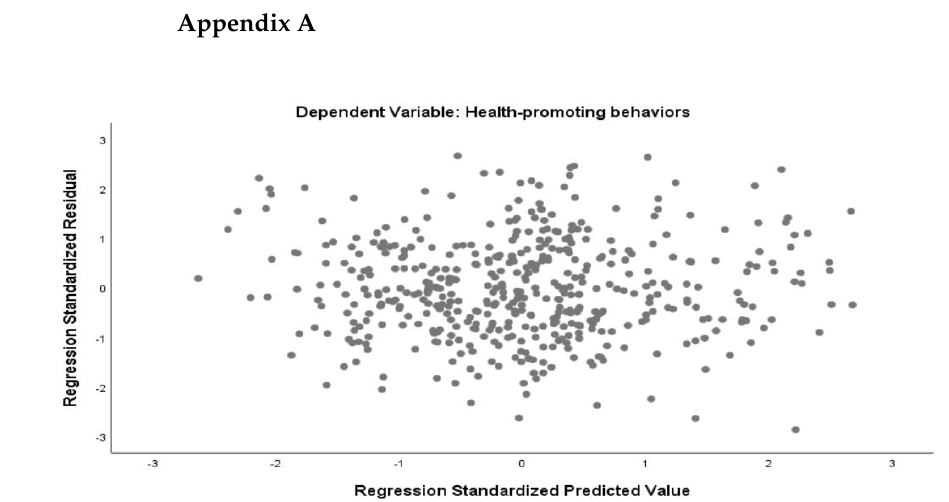
Figure A1. Scatter plot of standardized predicted value and standardized residual.